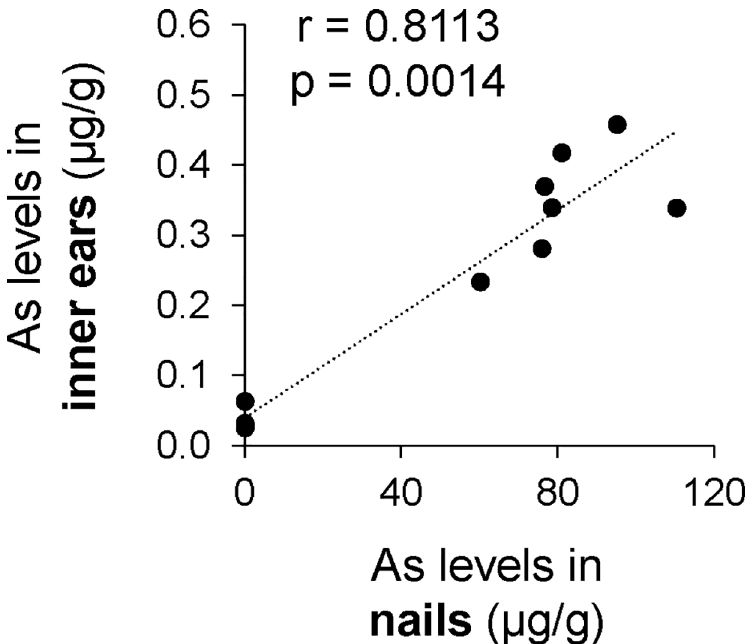
Fig 2. Correlation between As levels in inner ear and nails in mice. Correlation between As levels in inner ears and nails was determined by Spearman correlation